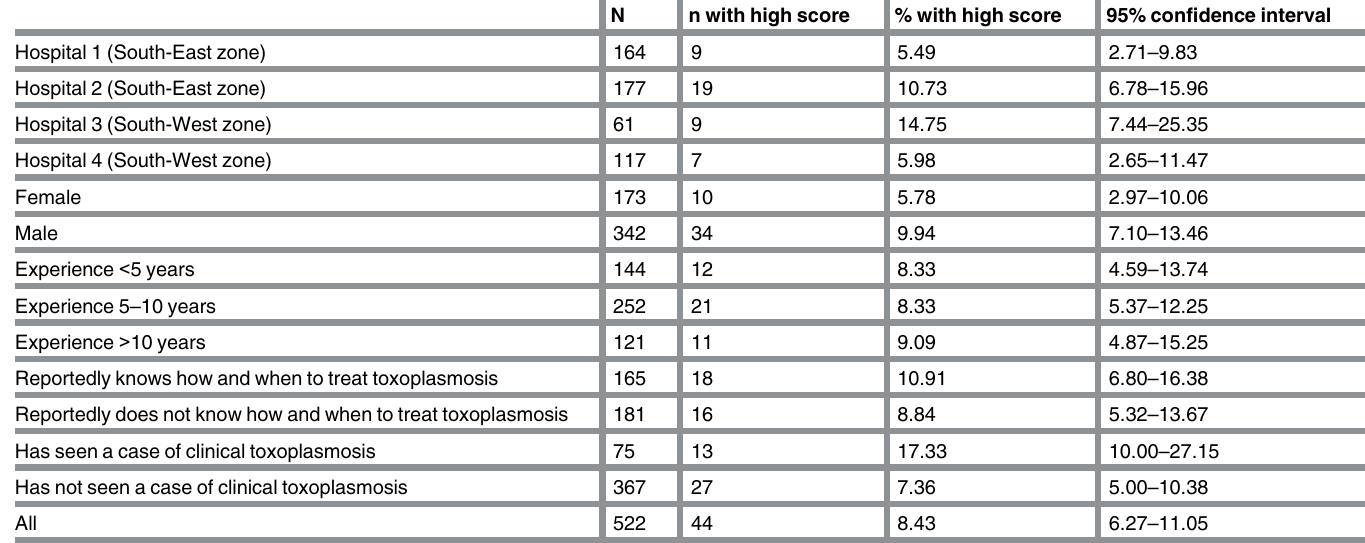
Table 1. Proportion of medical doctors scoring a high knowledge score in the questionnaire surveying knowledge on toxoplasmosis in Nigeria, by their background